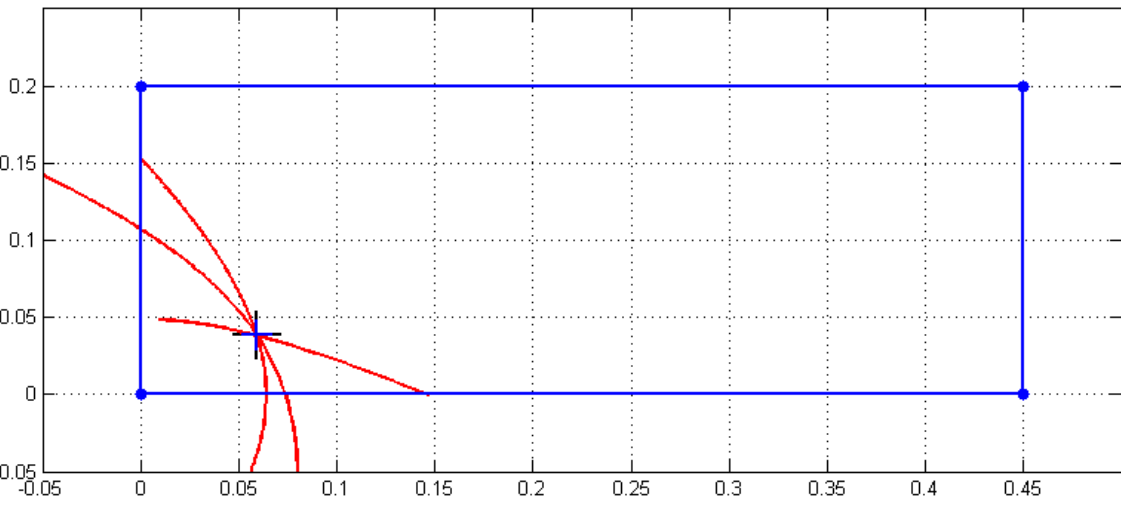
Figure 14. A mean absolute error of 0.391 mm with a standard deviation of σ = 0.236 mm can be obtained from this